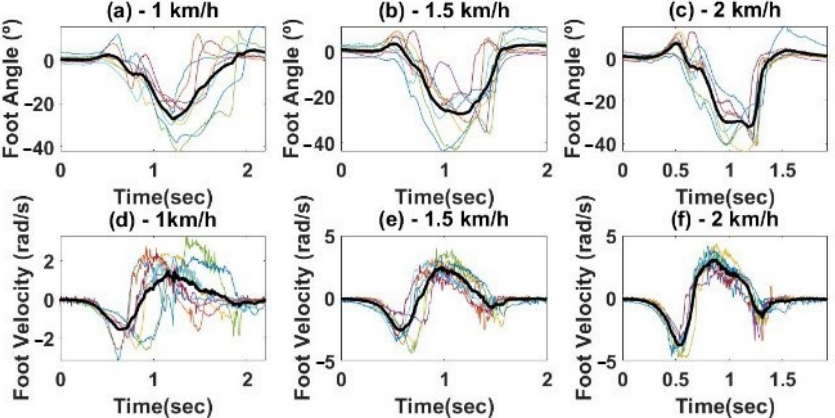
Figure 5. Reference Trajectories for different speeds, ( a , d ) 1 km/h; ( b , e ) 1.5 km/h; ( c , f ) 2 km/h. Foot angle ( top ) and angular velocity ( bottom ). The bold lines represent the final trajectories obtained from averaging all the subject’s trajectories (thin lines).